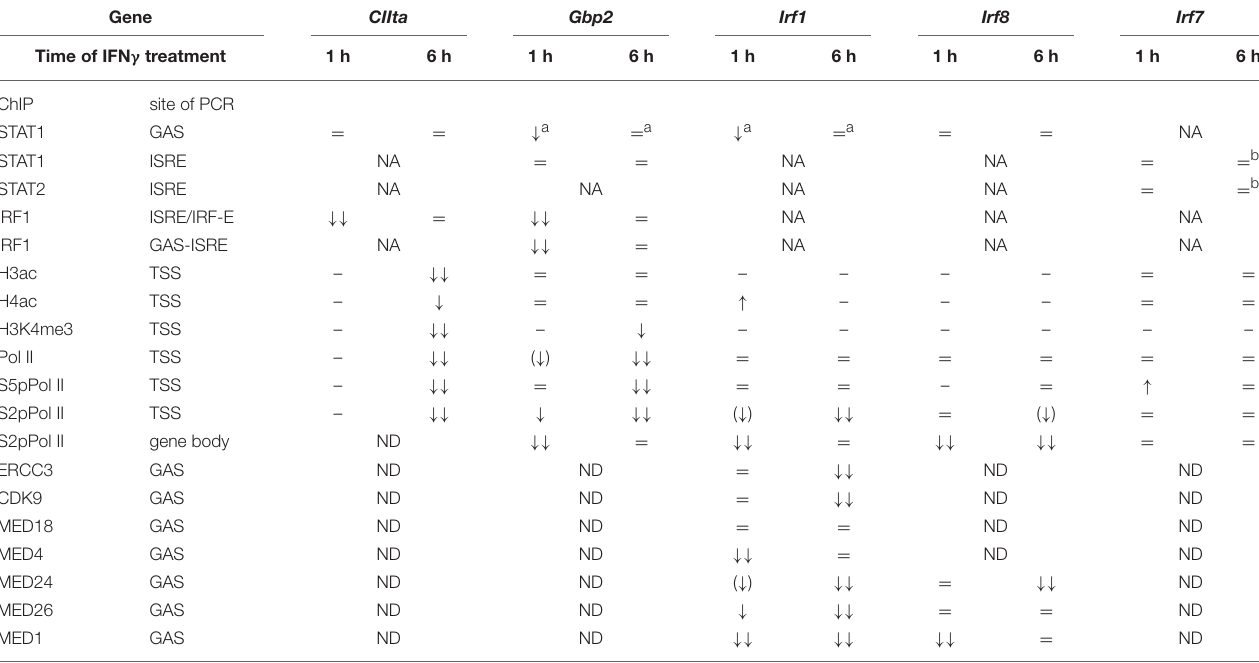
TABLE 1 | Summary of ChIP results at 1 and 6h after IFN γ treatment. Gene